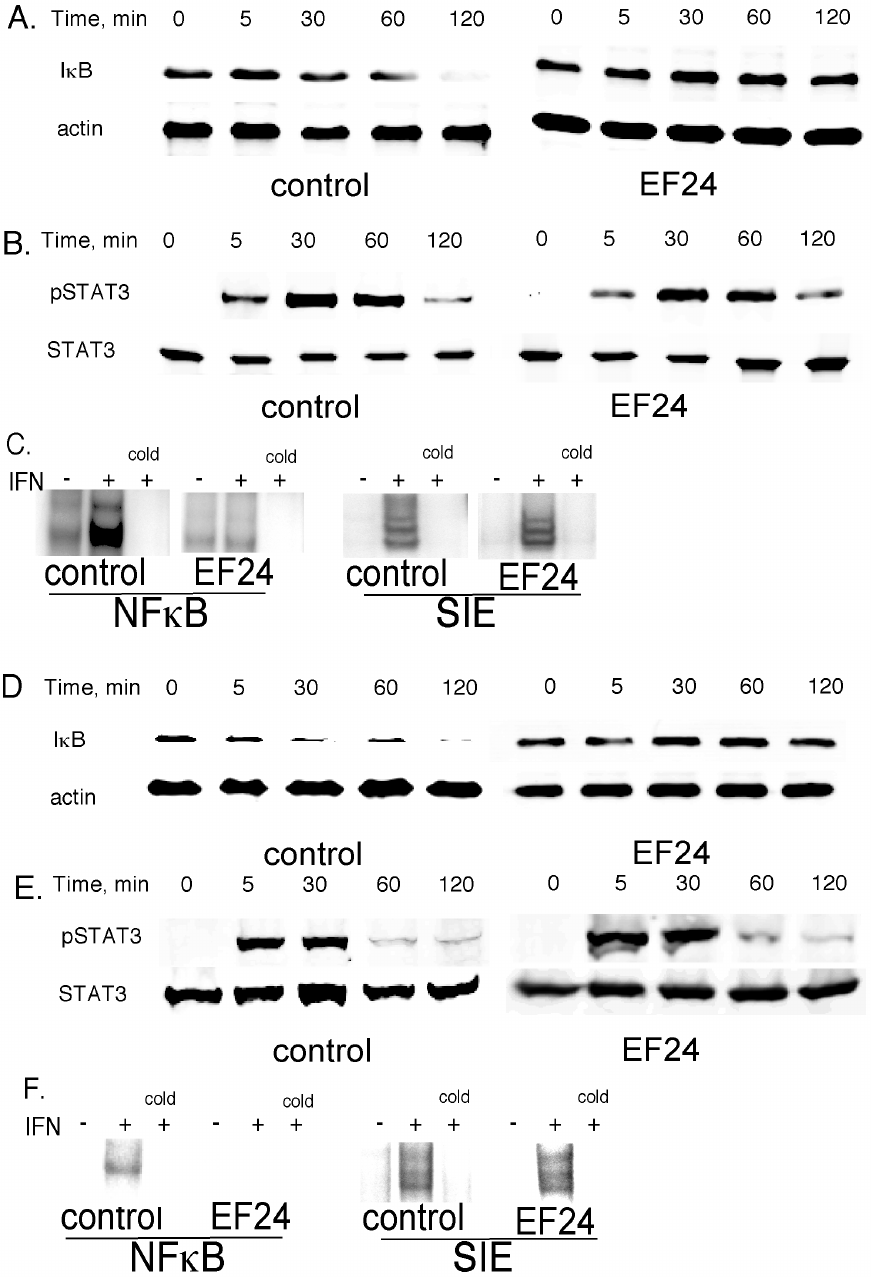
Figure 2. The effects of EF24 on STAT and NF- k B activation invitro . DU145 (A,B) and B16 (D,E) cells were treated with EF24 (5 m M) or vehicle (control) for 24 hr prior to stimulation with IFN (1000 IU/ml) for the indicated times. Whole cell extracts were prepared and immunoblotted for (A,D) I k B and actin, or (B,E) phosph-STAT3 and STAT3. (C,F) Nuclear extracts were prepared from IFN-stimulated cells (1000 IU/ml for 30 min) DU145 (C) or B16 (F) cells pretreated for 24 hr with EF24 (5 m M) or vehicle (control) and subjected to EMSA with oligonucleotide probes for NF- k B or SIE. A 50-fold excess of unlabeled probe (cold) was used to show the specificity of binding. Representative results from at least three experiments are shown.